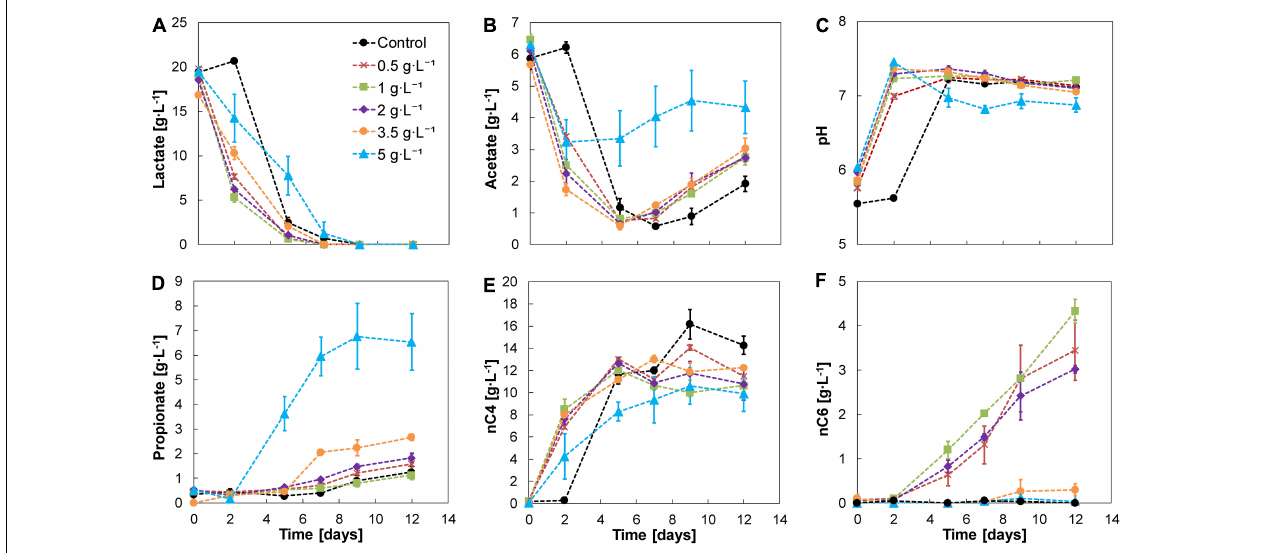
FIGURE 2 | Experiment II—Substrates (A,B) , pH (C) , and metabolites (D–F) profile of lactate-based chain elongation with different nZVI concentrations. Error bars show duplicates absolute deviation from the